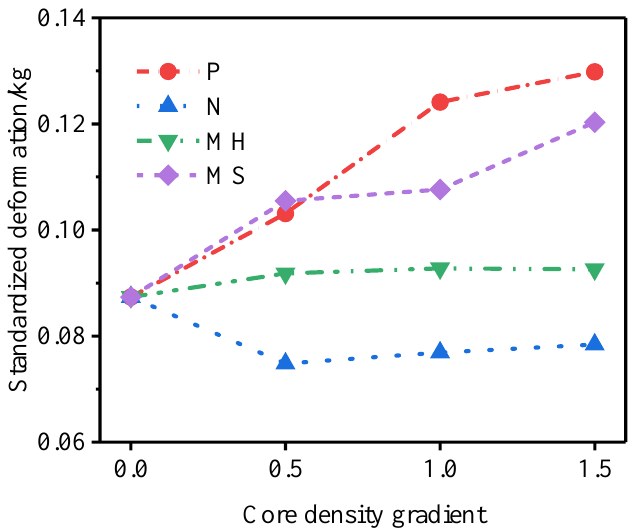
( b ) Figure 17. Anti − explosion performance of an MH-type aluminum foam sandwich tube. ( a ) Defor- mation curve of the outer tube and ( b ) specific energy absorbed by the sandwich tube. Figure 18 shows the influence of different core density gradients on the deformation of the outer tube. Figure 19 shows the specific energy absorption of the foam core under different core density gradients. Under the three core density gradients, the deformation of the outer tube of the N-type sandwich tube and the specific energy absorption of the